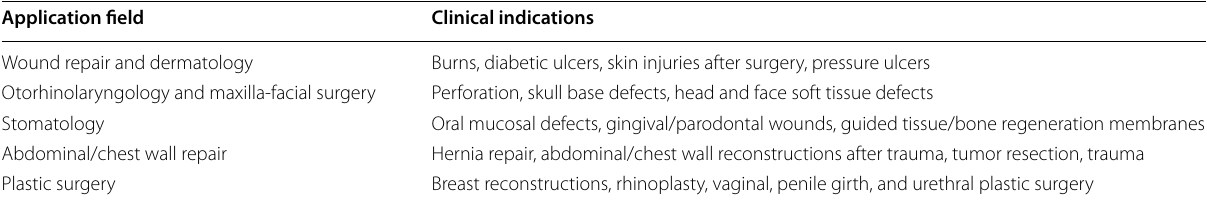
Table 2 Common clinical indications of ADMs Application